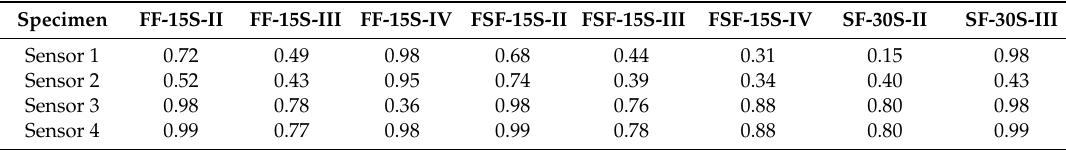
Table 5. Correlation coe ffi cient between signals obtained by a post-embedded piezoceramic sensor and applied force under dynamic testing.